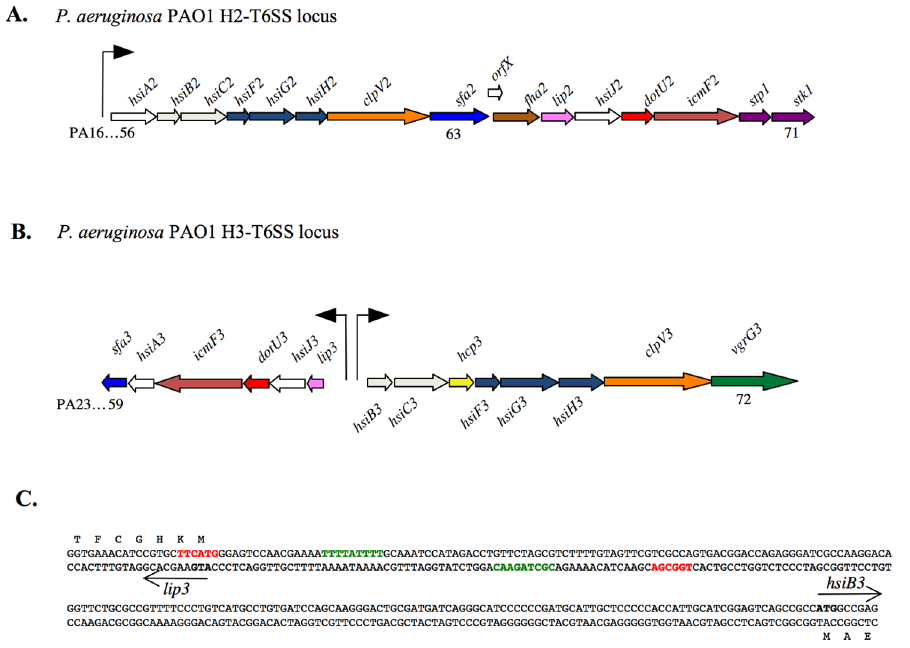
Figure 2. The P.aeruginosa PAO1 H2- and H3-T6SS gene clusters. A . H2-T6SS is organized in one putative operon (from [14]). B. H3-T6SS is organized in two putative operons. The genes are labeled hsiA3 to hsiJ3 for the left operon and hsiB3 to hsiH3 for the right operon and, where applicable, with the given name, i.e., clpV3 or sfa3 . Gene annotation numbers are also indicated (e.g. PA2359). The promoter region of each operon is also shown. C. The intergenic sequence between lip3 and hsiB3 genes is represented. The –35 box and the –10 box of the s 70 promoters predicted by Bprom are highlighted in green and red respectively. The translation initiation codons of lip3 and hsiB3 genes are underlined. 486 bp of the left operon upstream region and 494 bp of the right operon upstream region were used for the transcriptional fusions, which are encoded by pTS19 and pTS20 respectively.